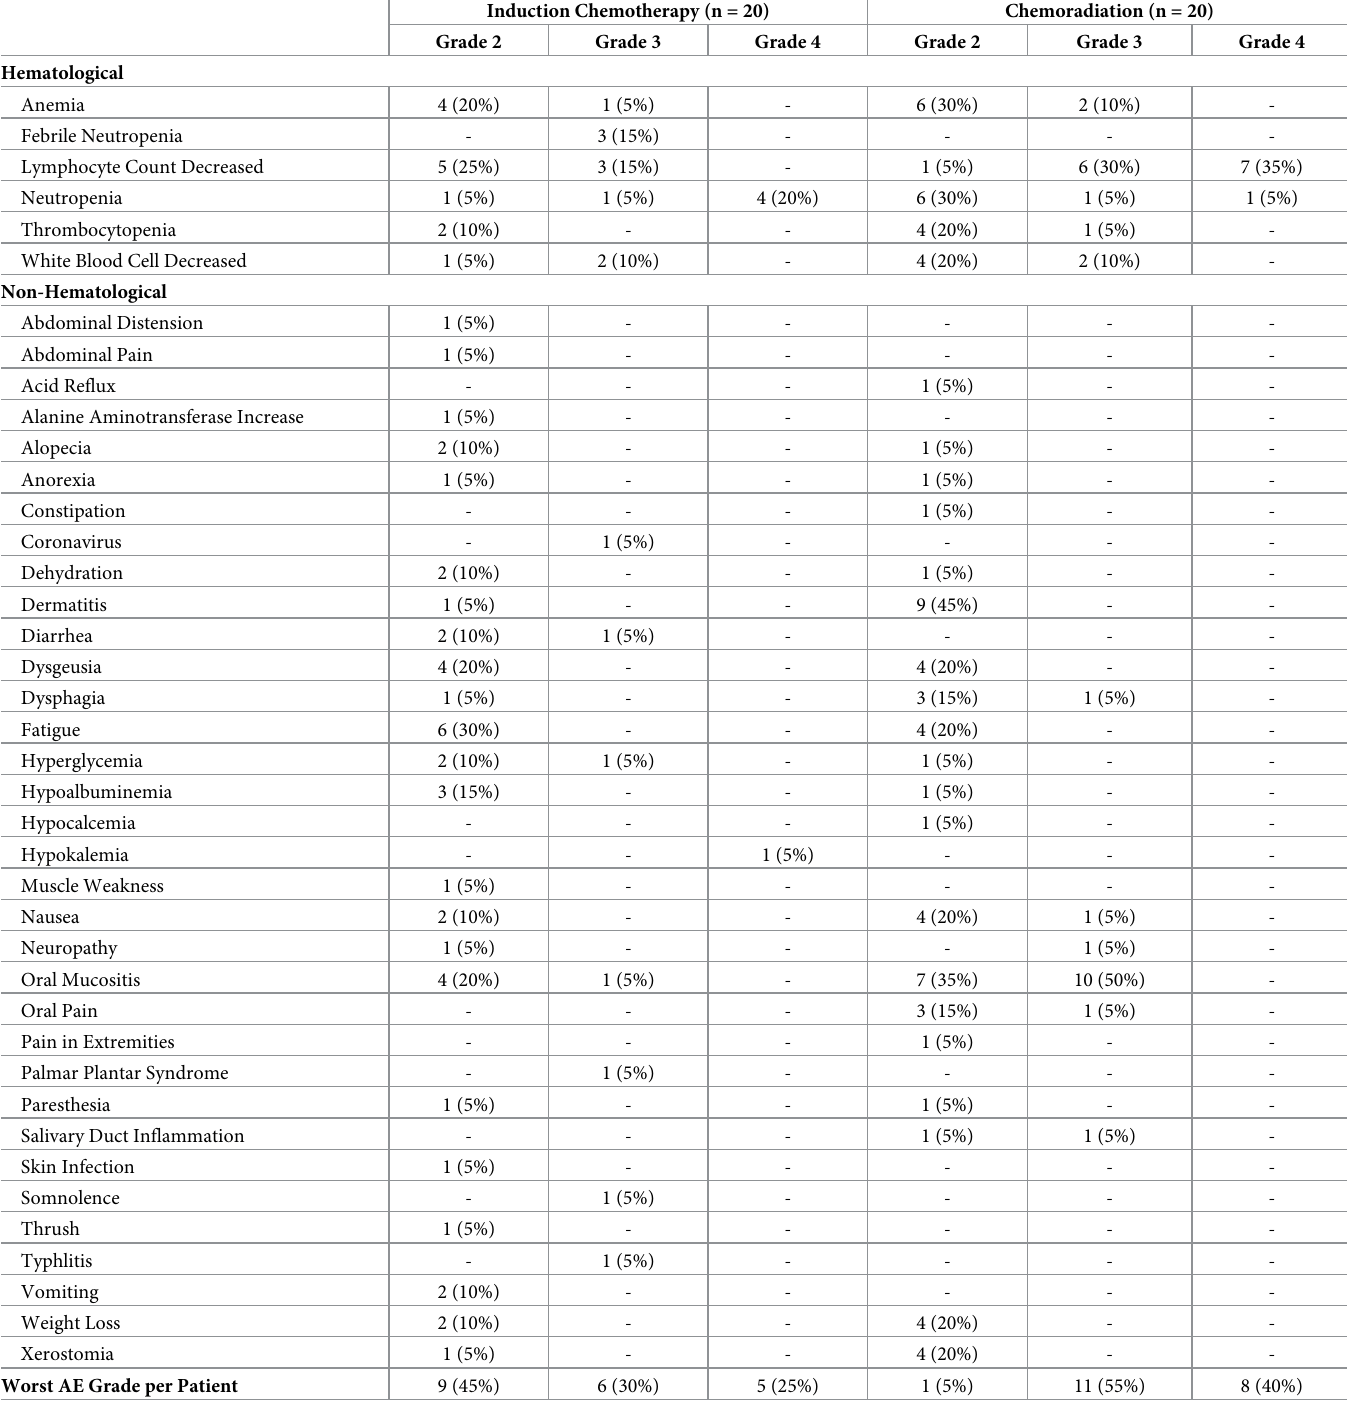
Table 3. Adverse events of M0 cohort, worst grade per patient for each